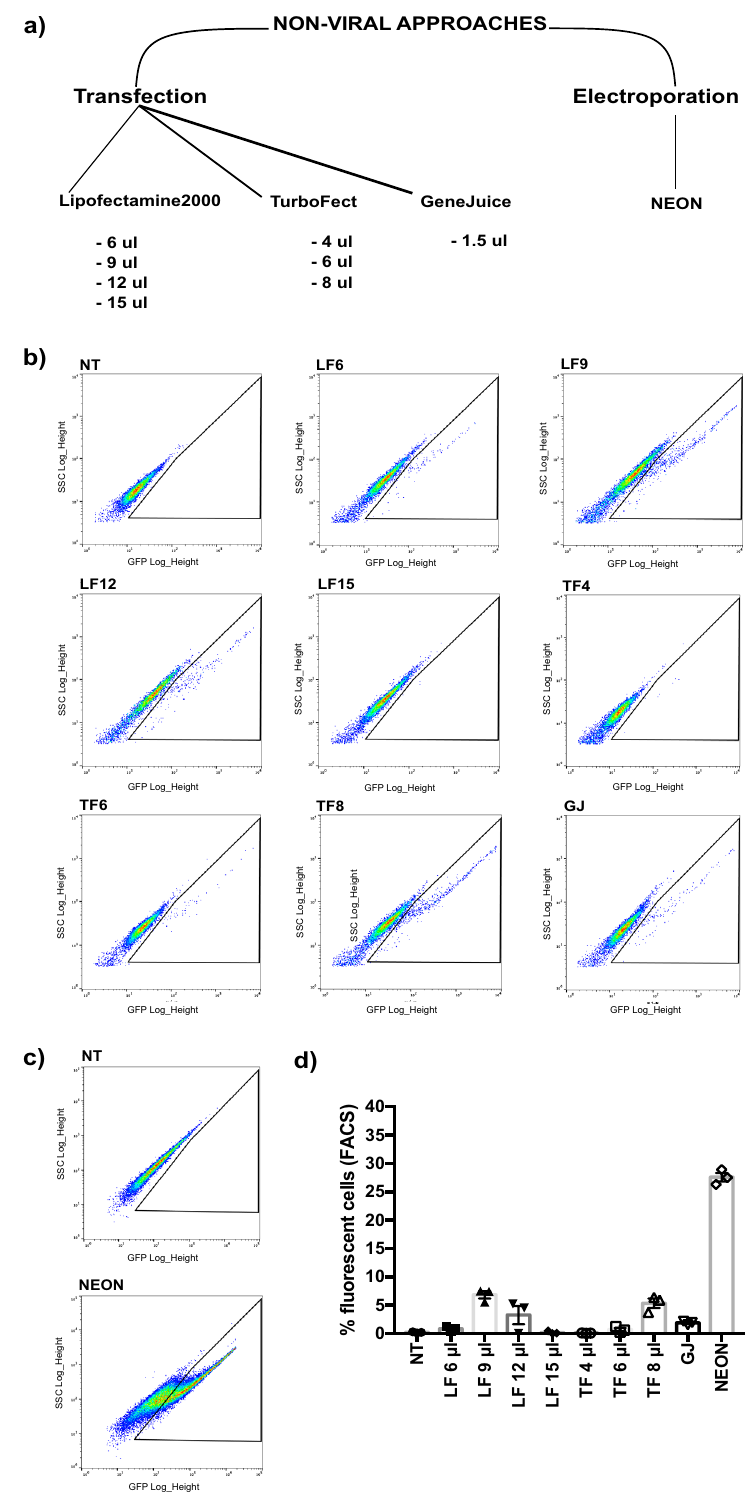
Figure 2. Screening of non-viral methods to deliver CRISPR/Cas9 in primary myoblasts. ( a ) Schematic of tested non-viral technologies and used doses. ( b ) FACS analysis of pCMV-GFP plasmid expression in DUPmyo cells following transfection. Lipofectamine2000 (LF), TurboFect (TF) and GeneJuice (GJ). Lipofectamine2000 doses were 6 μl (LF6), 9 μl (LF9), 12 μl (LF12) and 15 μl (LF15). TurboFect was tested at a dosage of 4 μl (TF4), 6 μl (TF6) and 8 μl (TF8). GeneJuice (GJ) was tested at a single concentration. ( c ) FACS analysis of DUPmyo cells electroporated with the pCMV-GFP plasmid using the NEON device. ( d ) Comparison of the efficiencies of tested techniques (n = 3/technique) for plasmid delivery in DUPmyo